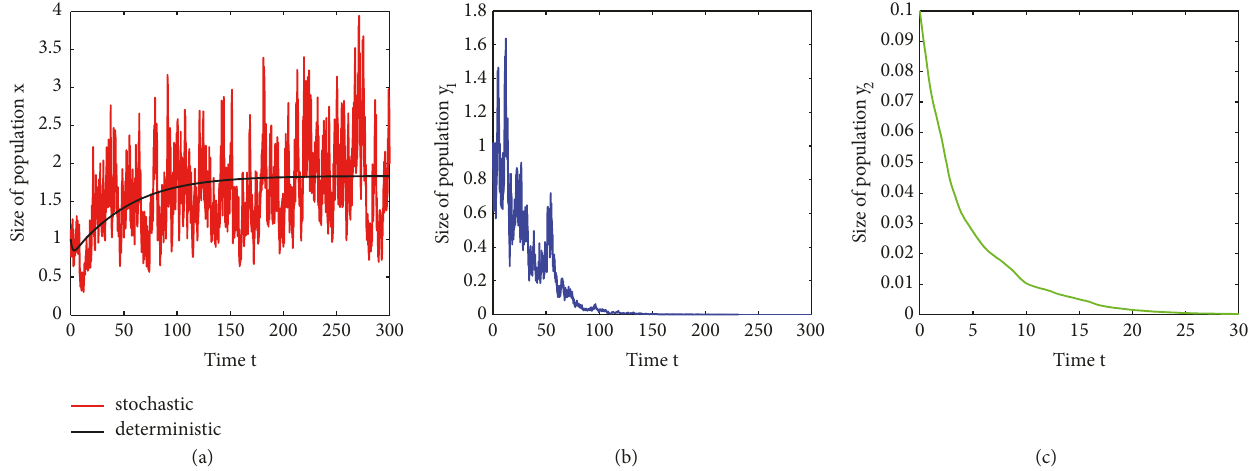
Figure 4: Numerical simulation of the solution of model (6). The parameters of model (6) are 𝑎 = 0.55 , 𝑏 = 0.3 , 𝑐 = 0.38 , 𝜂 = 0.5 , 𝑑 = 0.4 , ̂𝑒 = 0.23 , 𝑓 = 0.3 , 𝛿 = 0.1 , 𝑔 = 0.1 , and 𝜎 2